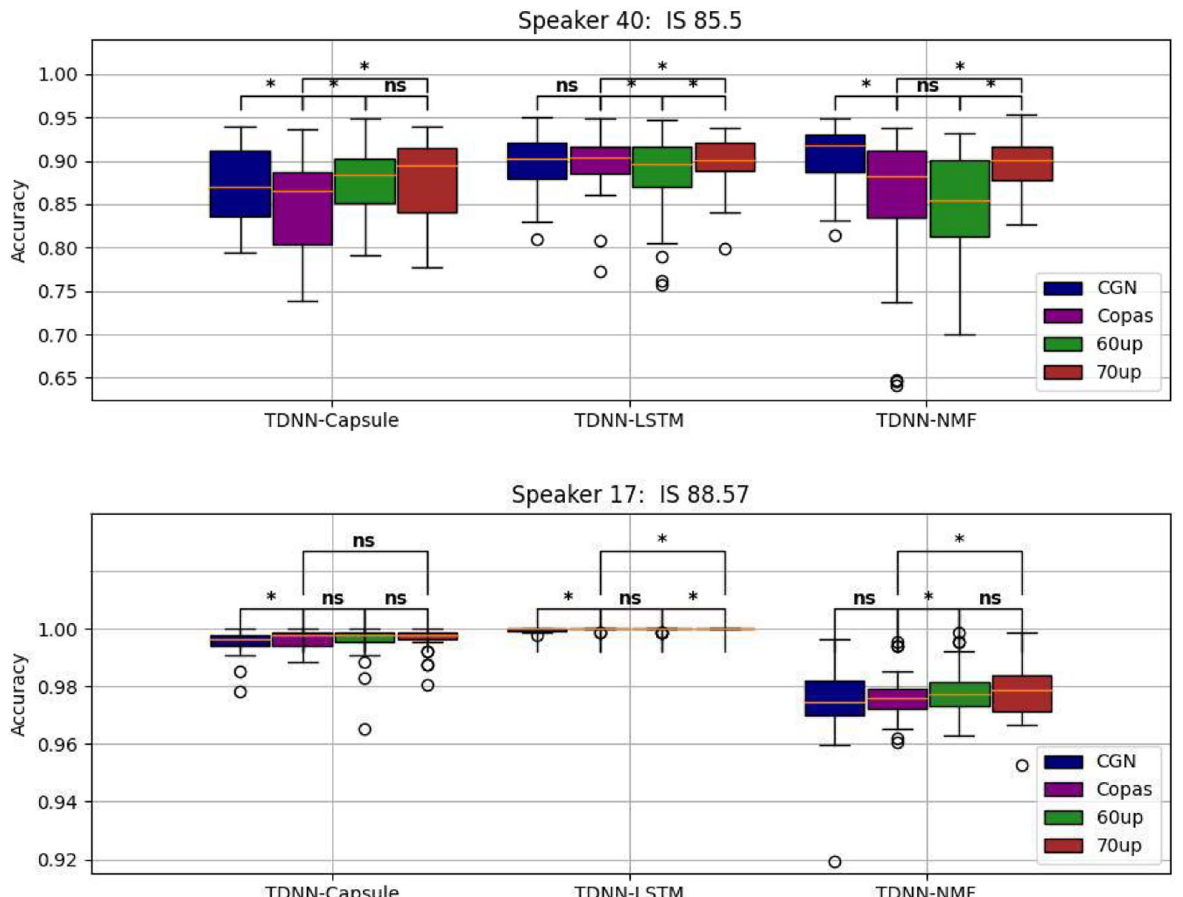
Fig. 14 Performance of the TDNN acoustic models combined with the capsule network, LSTM, and NMF decoder for SLU with insufficient task-specific training data for the speaker 40 and the speaker